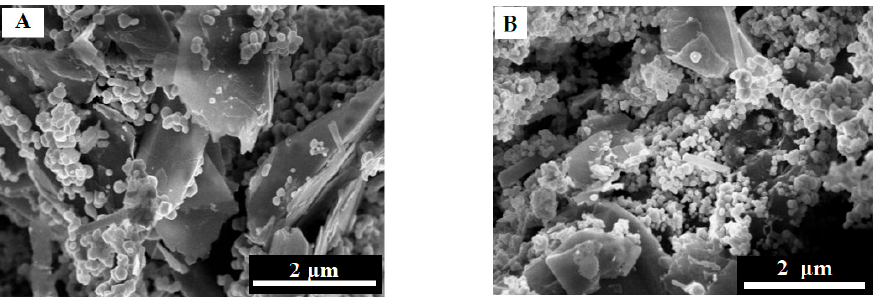
Figure 17. SEM images of CuFe 2 O 4 -70%/rGO/HNT before ( A ) and after ( B ) five cycles of regenera- tion.